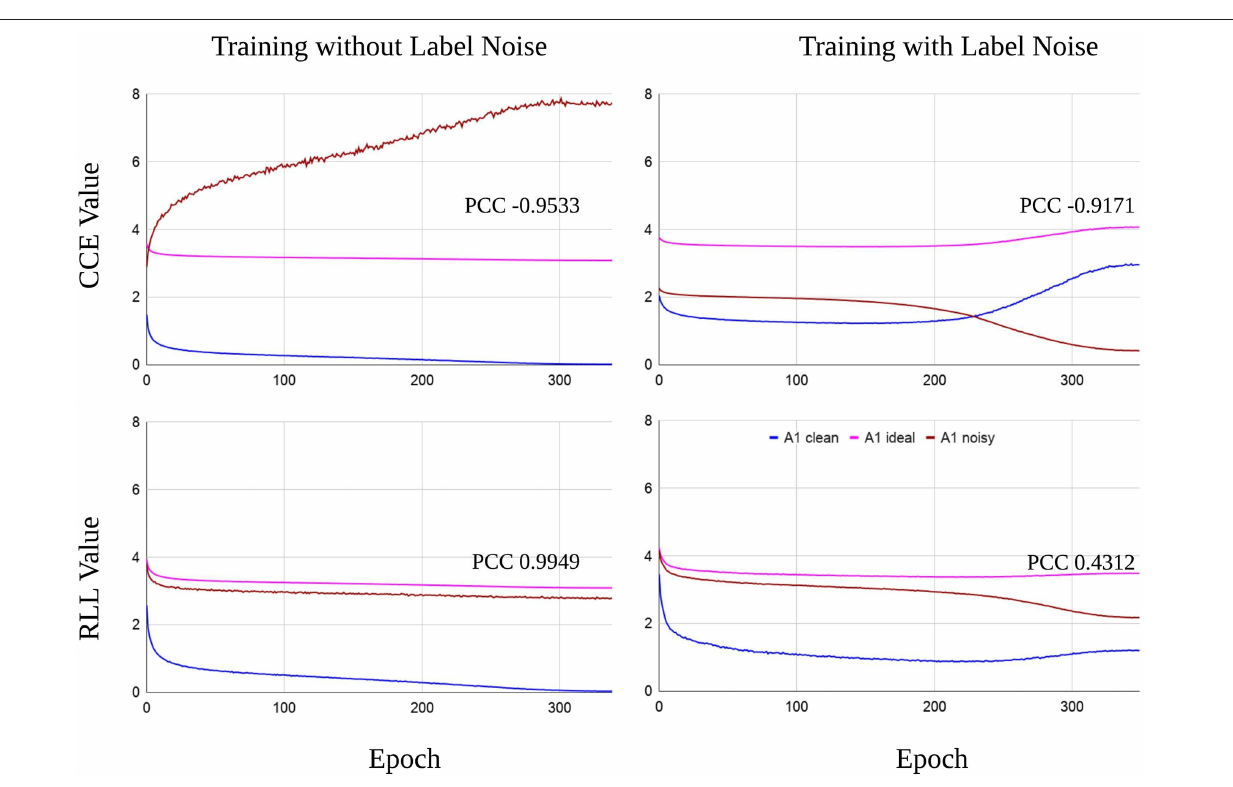
FIGURE 1 | The empirical risk of the first network (depicted in Table 2 ). The symmetric noise of η = 0.6 is introduced in training labels. The curves of empirical risk (A1 clean and A1 noisy) are from training the network by CCE or RLL ( α = 0.01). The ideal curve (A1 ideal) for the noisy risk is computed from Proof 1 of section 3 with